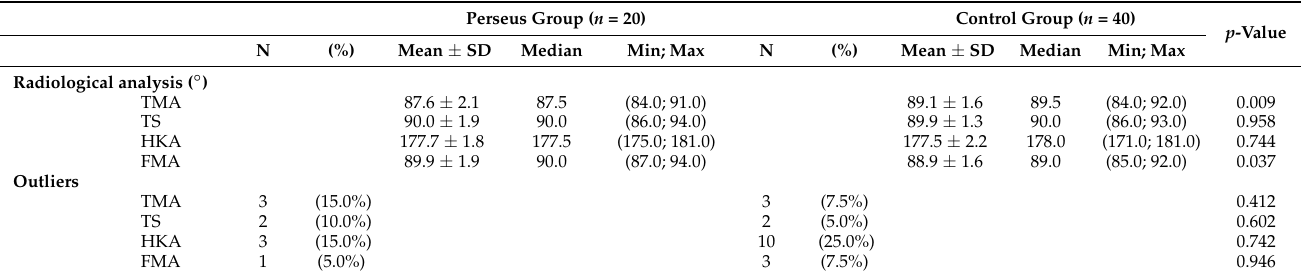
Table 2. Post-operative results.